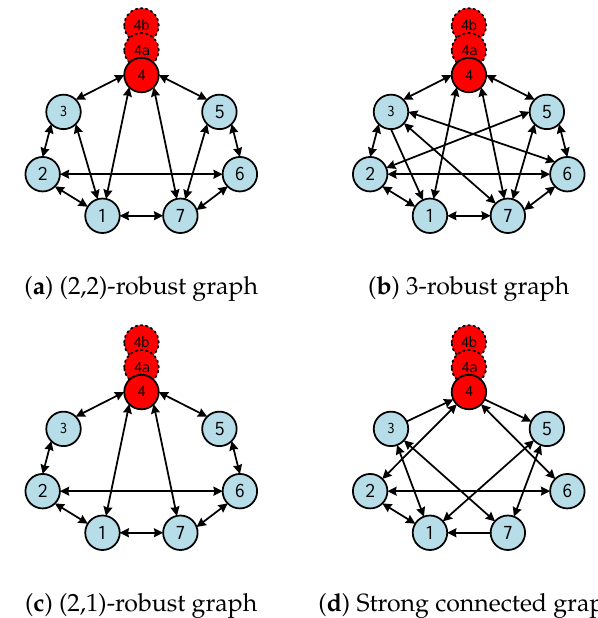
Figure 5. Network topology of MAS with 7